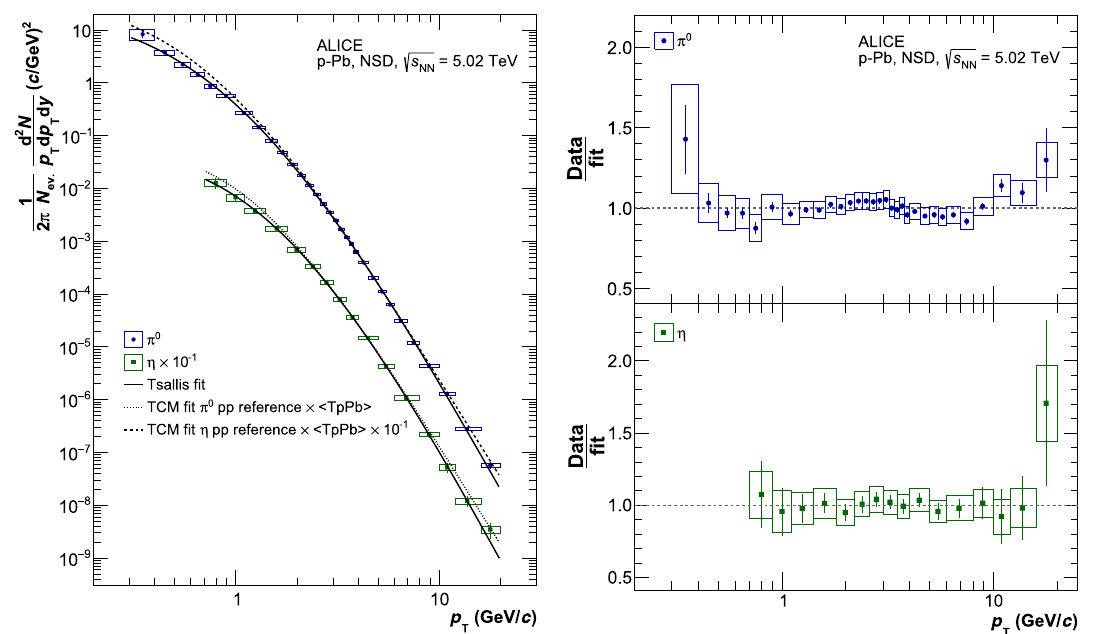
Fig. 5 Left: invariant differential π 0 and η yields produced in NSD to the measured yields are shown. The TCM fit to the (cid:9) T pPb (cid:10) scaled π 0 √ s p–Pb collisions at − 1 . 365 < y cms < 0 . 435 at and η pp reference spectra (see Sect. 5.3 for details) is shown. Right: NN = 5.02 TeV. The statistical uncertainties are represented as vertical error bars whereas Ratios of the measured data to their corresponding Tsallis fits the systematic uncertainties are shown as boxes. In addition, Tsallis fits